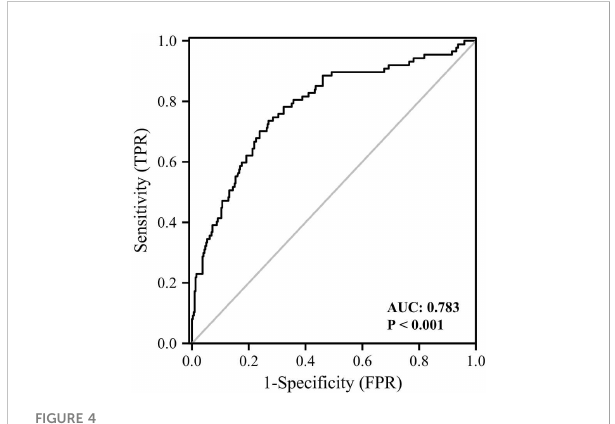
FIGURE 4 ROC curve analysis of the ability of plasma GPNMB to predict the presence of cataract. AUC, area under curve.